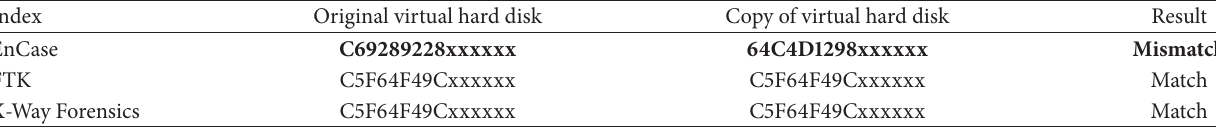
Table 13: Comparison of hash values for various tools.